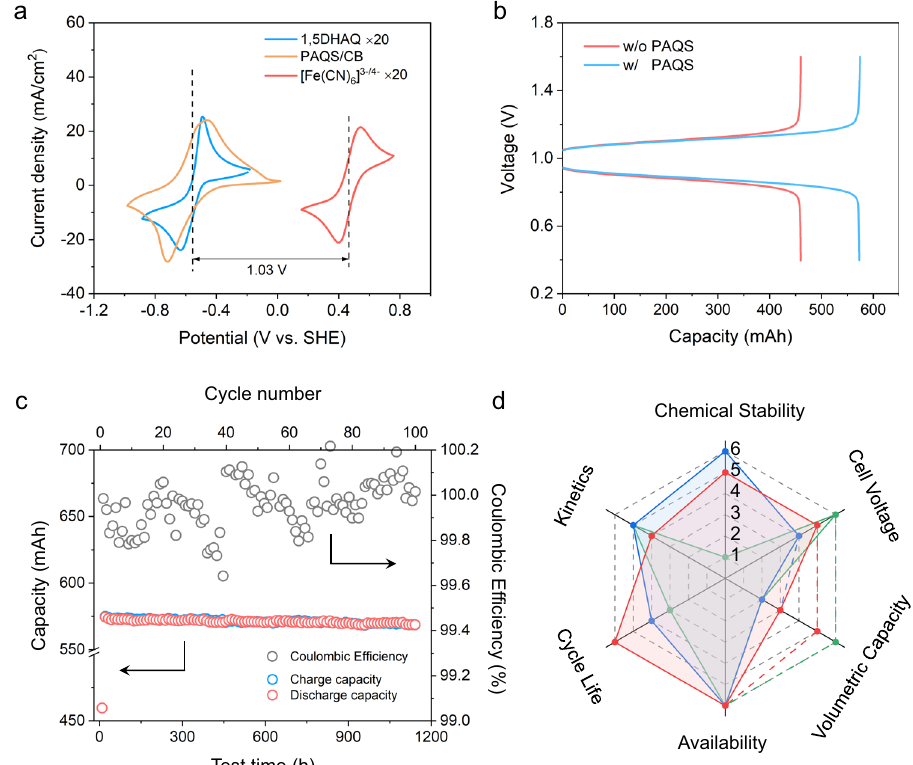
Fig. 4 | Electrochemical performance of 1,5-DHAQ/PAQS/CB systems and itemized comparison with other quinone-based systems. a CV curves of 1,5- DHAQ,[Fe(CN) 6 ] 3 − /4 − andPAQS/CBin1MKOH.Thescanratewas50mV/s. b Voltage pro fi les of 1,5-DHAQ|[Fe(CN) 6 ] 3 − /4 − fl ow cell with (2nd cycle) and without (1st cycle) PAQS/CB granulesloadedin the anodic tank at 20mA/cm 2 . c Coulombic ef fi ciency and capacity retention of a fl ow cell at prolonged cycling test. The catholyte was 250mL 0.25M K 4 Fe(CN) 6 +0.05M K 3 Fe(CN) 6 /1M KOH; the anolyte was